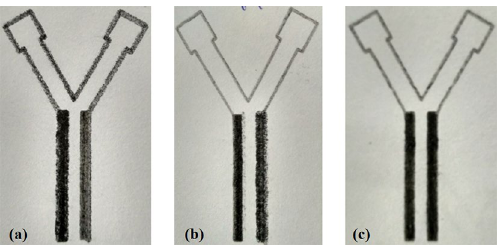
Figure 1. Automated graphite pencil stroke electrodes combinations with different strokes, ( a ) 8B-HB at 10 strokes, ( b ) 8B-HB at 15 strokes, and ( c ) 8B-HB at 30